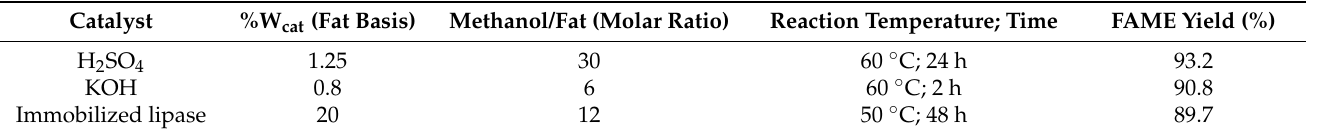
Table 3. FAME yields from tallow using different catalysts (data collected from [19]).